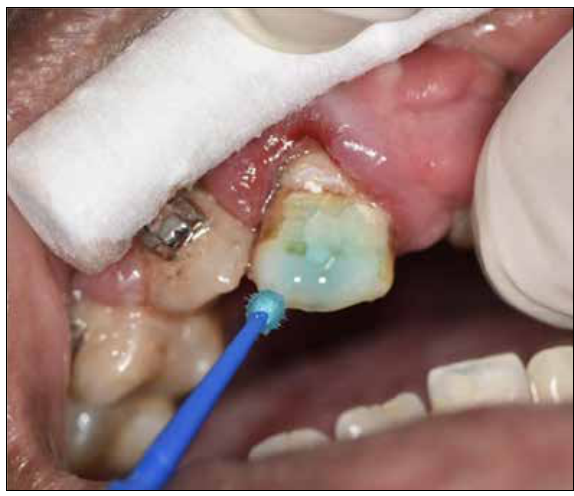
Figure 2. Condition the enamel surface with 10% polyacrylic acid for 10 seconds then rinse off with water leaving the surface moist.